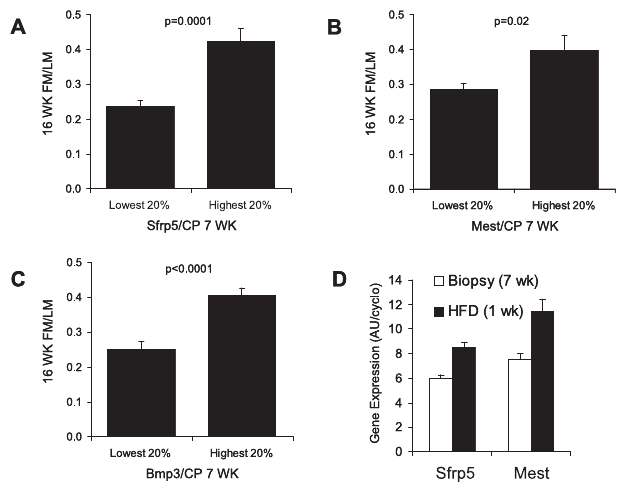
Figure 8. Analysis of mRNA Levels in Biopsies of Epididymal Fat Depots Taken from Mice 7 wk of Age prior to Feeding a High-Fat Diet Suggests That Changes in Gene Expression Exist before Mice Are Exposed to an Obesogenic Environment Mean adiposity (FM/LM) at 16 wk of age for the mice with the highest and lowest 20% expression of SFRP5 (A), MEST (B), and BMP3 (C) at 7 wk of age. SFRP5 and MEST were assayed by qRT-PCR and BMP3 by a TaqMan t Low Density Array. Each bar represents the mean FM/LM 6 SEM for 12 mice. (D) Induction of SFRP5 and MEST mRNA levels after being fed a high-fat diet at 8 wk of age for 1